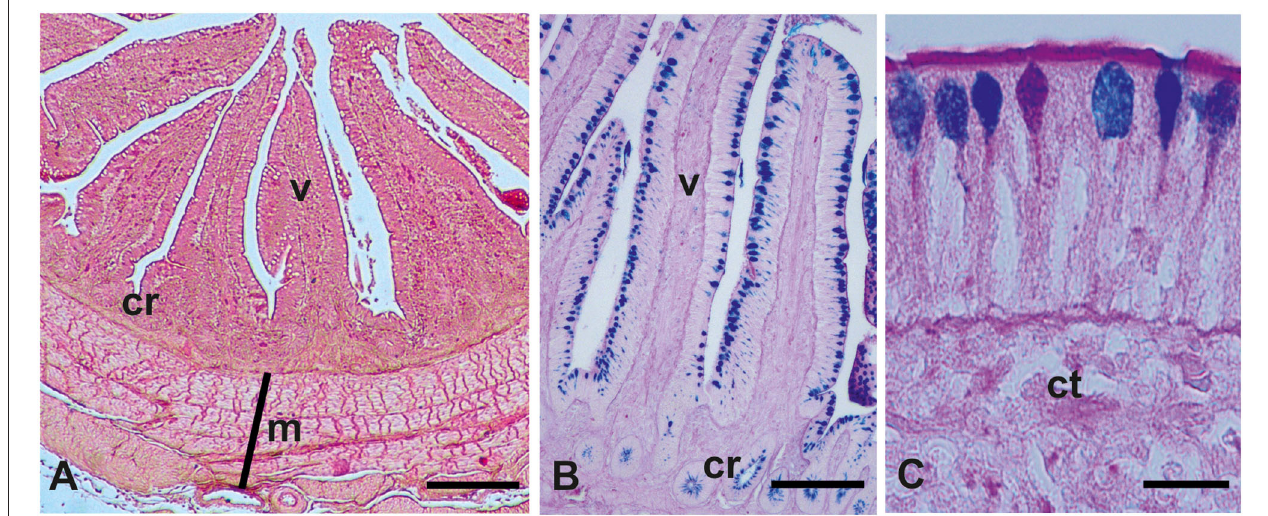
FIGURE 1 | Representative histological (A) and glicohistochemical (B,C) views of the guinea fowls ( Numida meleagris ) intestine. cr, crypts; ct, connective tissue; m, muscularis; v, villum. (A) Hematoxylin–eosin staining; (B,C) Alcian blue pH 2.5 (AB)/periodic acid–Schiff (PAS) staining. (C) Picture shows goblet cells producing acidic mucins (azur staining, AB positivity), neutral mucins (magenta staining, PAS positivity), and both acidic and neutral mucins (violet staining, AB/PAS positivity). Scale bars (A) 250 µ m, (B) 200 µ m, and (C) 15 µ